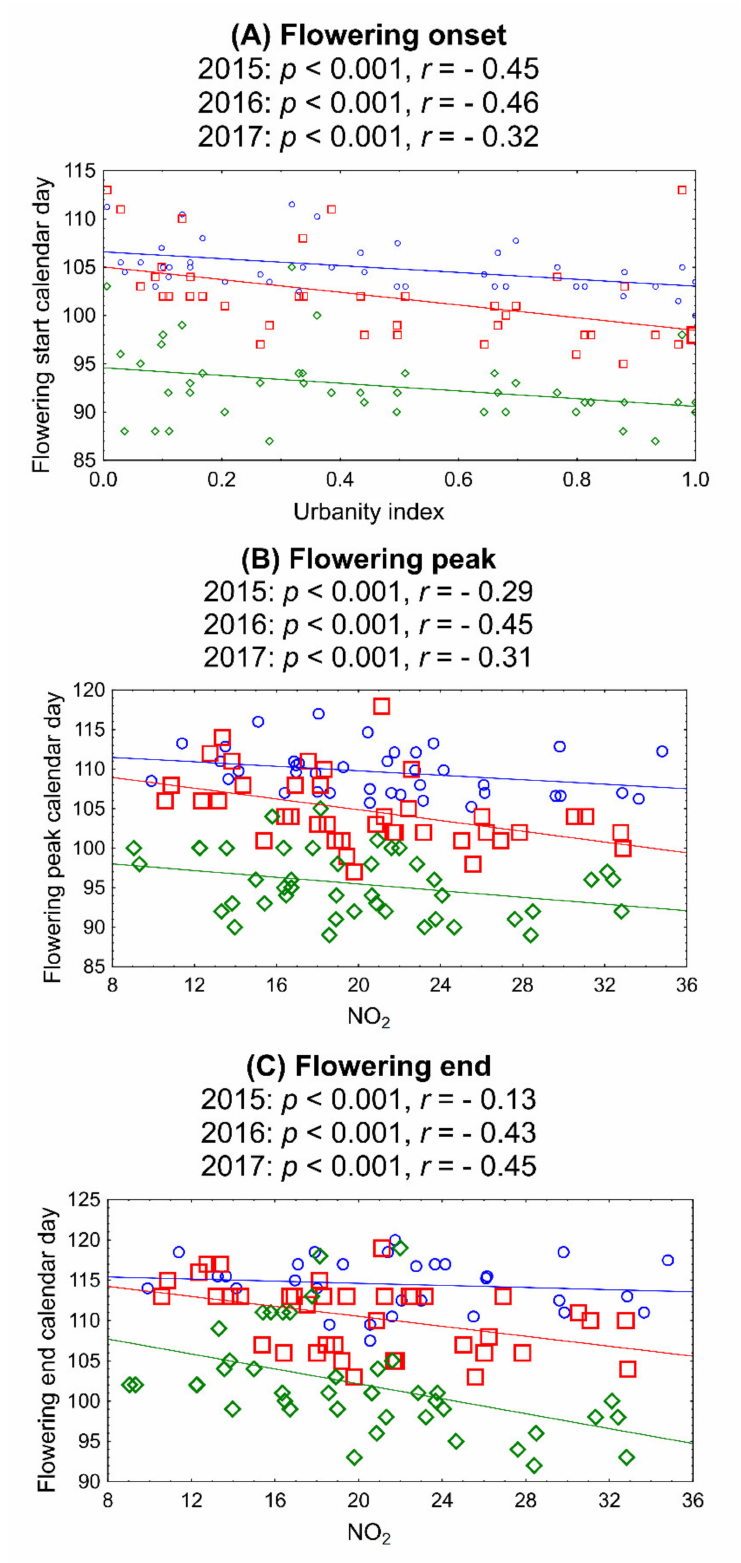
Figure 8. Relationships between flowering phenological traits and environmental parameters in Augs- burg, during 2015–2017 (linear regressions, per year, weighted for air temperatures). ( A ) Flowering onset vs. urbanity index, ( B ) flowering peak vs. NO 2 , ( C ) flowering end vs. NO 2 . Blue: year 2015, red: 2016, green: